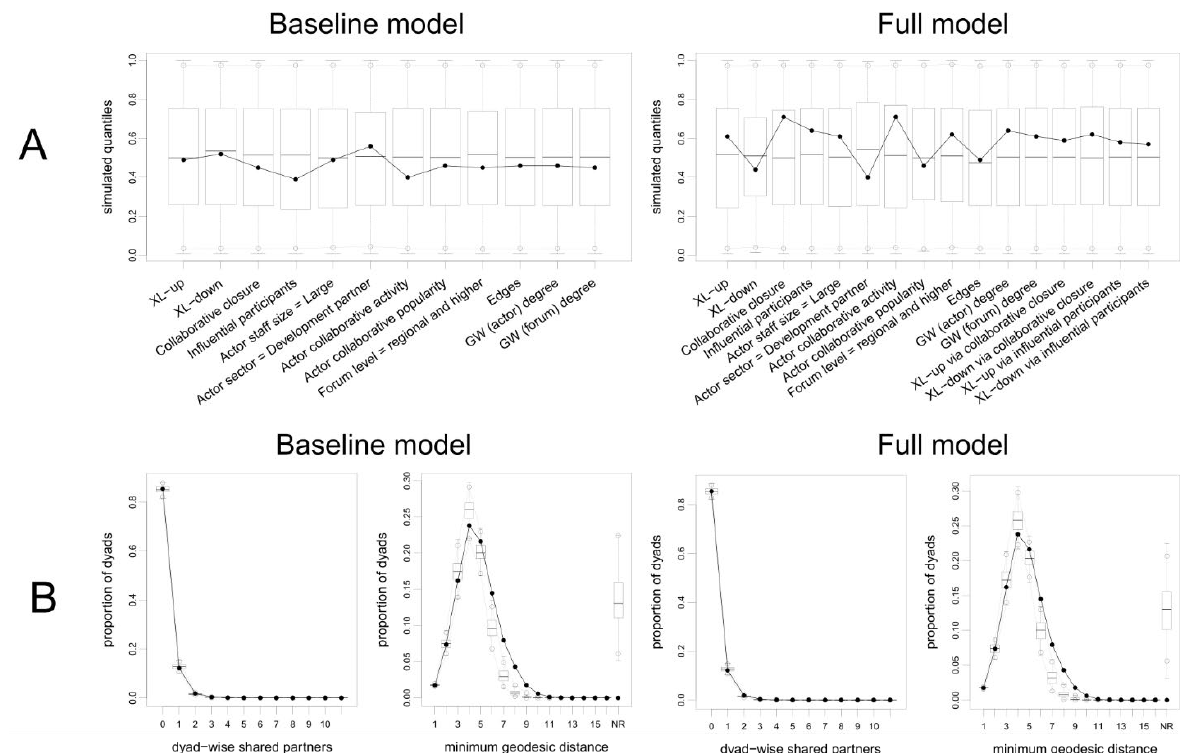
Figure A2.1 Goodness of fit of the exponential random graph models. In each plot, boxplots indicate statistics drawn from networks simulated using the model parameters, while the thick black line represents corresponding statistics from the observed